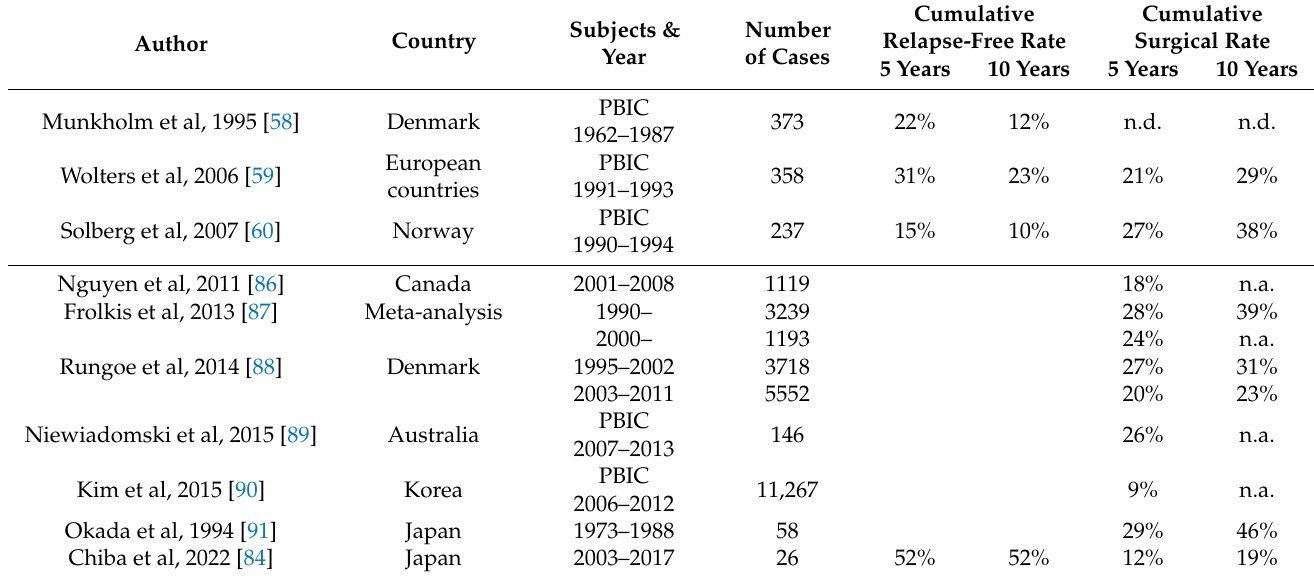
Table 5. Literature review of relapse-free rate and surgical rate in adult Crohn’s disease.